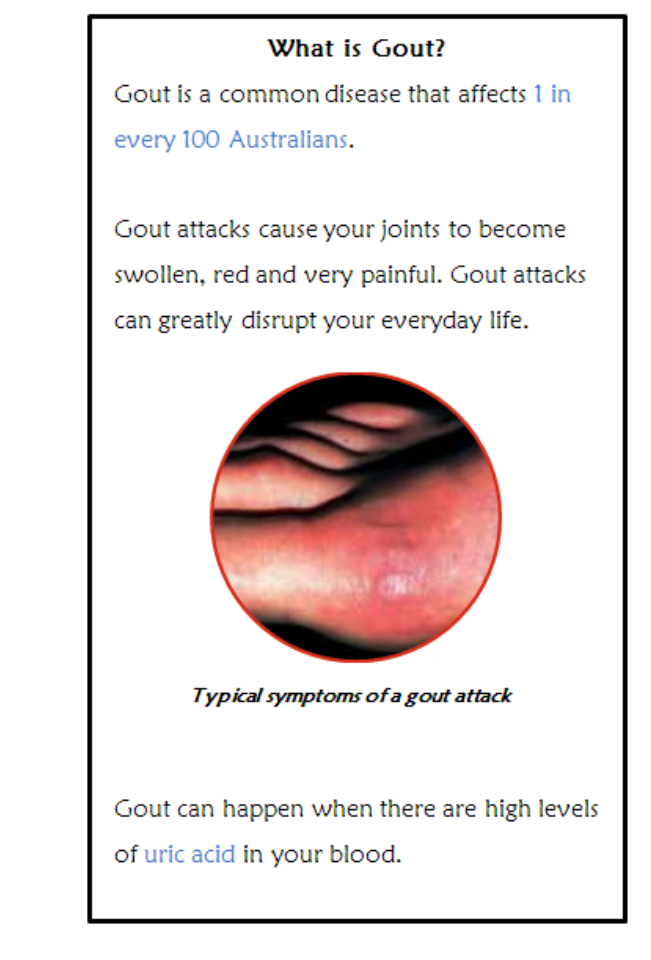
Figure 1. Example of the paper prototype of written educational materials shown to gout